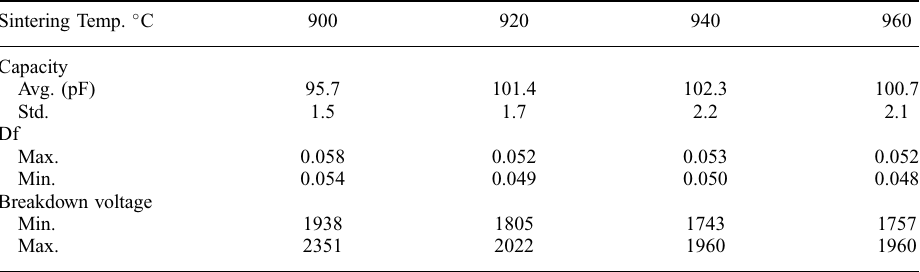
TABLE IV Comparison of Electrical Performance at Different Sintering Temperatures, Ag = Pd 90 =